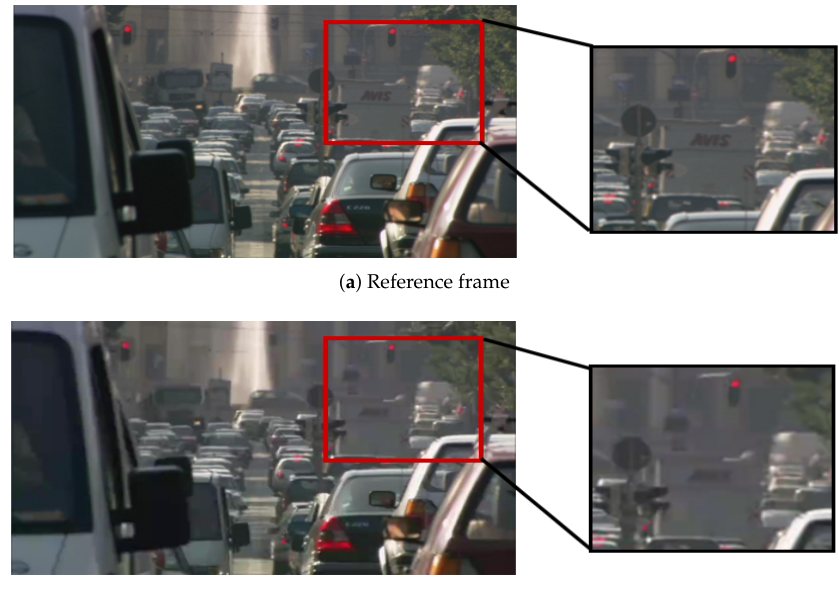
Figure 2. An example of blurring [23–25]. (2) Blocking: Standard video compression techniques utilize blocks of different sizes as basic units for frequency transformation and quantization. The quantization errors introduced in each block are presented in different forms, which result in discontinuities on block boundaries. In decoded videos, different forms of the blocking artifact are demonstrated, such as mosaic artifact, ladder artifact and pseudo-edge artifact. Blocking refers to discontinuities on the boundaries of adjacent blocks. The visual shape of blocking depends on the region where blocking occurs [26]. A blocking artifact example is shown in Figure 3b, which demonstrates the visual blocks of the face field.